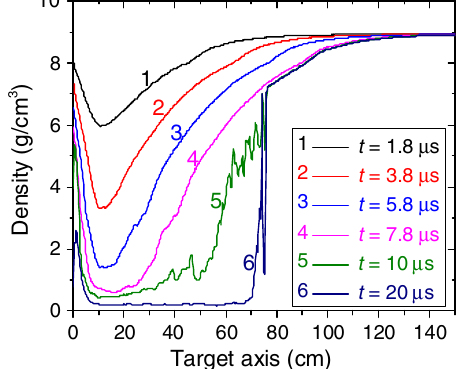
FIG. 11. Density along the target axis at different times of t ¼ 1 . 8 , 3.8, 5.8, 7.8, 10, and 20 μ